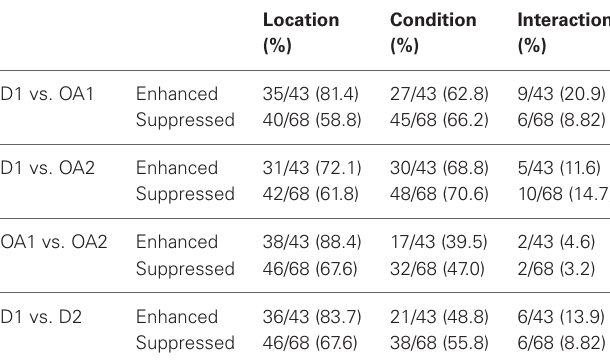
Table 2 | Results of 2 factor ANOVA of memory period activity for all cells.